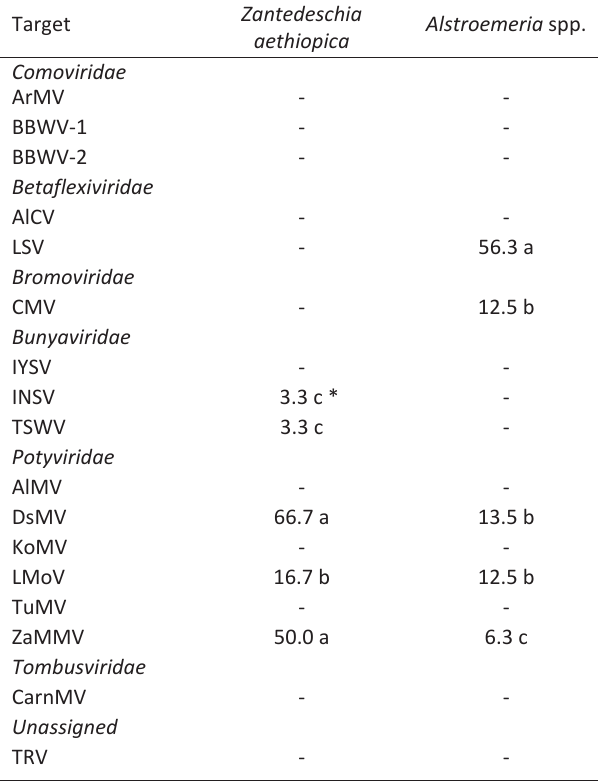
Table 2 - Health status of Calla lily ( Zantedeschia aethiopica ) and Peruvian lily ( Alstroemeria spp.) expresse d as percenta- ge of infected